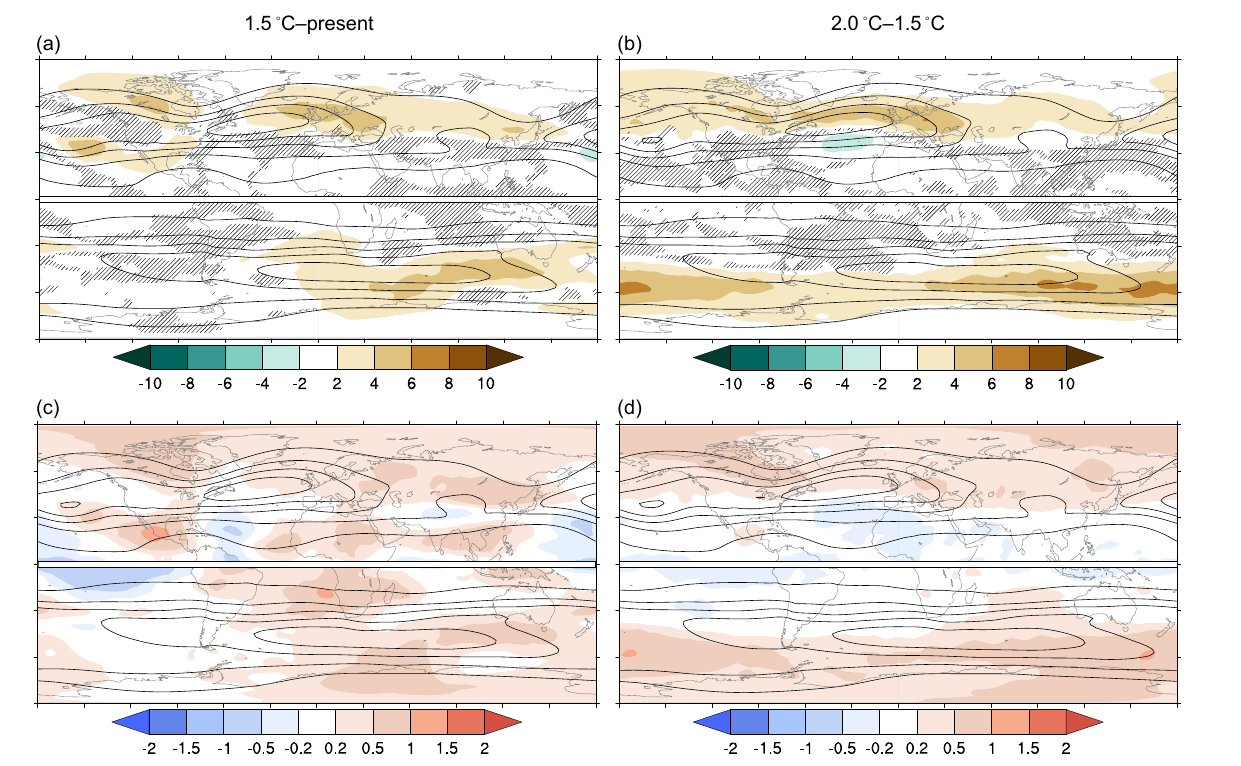
Figure 9. Multi-model mean response of winter (Northern Hemisphere DJF, Southern Hemisphere JJA) upper level EKE storm tracks for 1.5 ◦ C–PD (a, c) and 2.0–1.5 ◦ C (b, d) . Panels (a) and (b) show responses (shading; units m 2 s − 2 ) along with the climatology (contour interval 40m 2 s − 2 ) for the (a) PD and (b) 1.5 ◦ C experiments. Panels (c) and (d) show signal-to-noise ratio β/σ , where the sign corresponds to the sign of the response, along with the climatology (contour interval 40m 2 s − 2 ) for the (c) 1.5 ◦ C and (d) 2.0 ◦ C experiments. In (a) and (b) , hatching masks out regions where there is no model consensus (fewer than four out of five models agree) on the sign of the response. In (c) and (d) , black dots mask out regions where the models do not agree on the magnitude of the response ( f 2 > 1). The storm tracks are defined as EKE calculated from bandpass filtered daily wind at